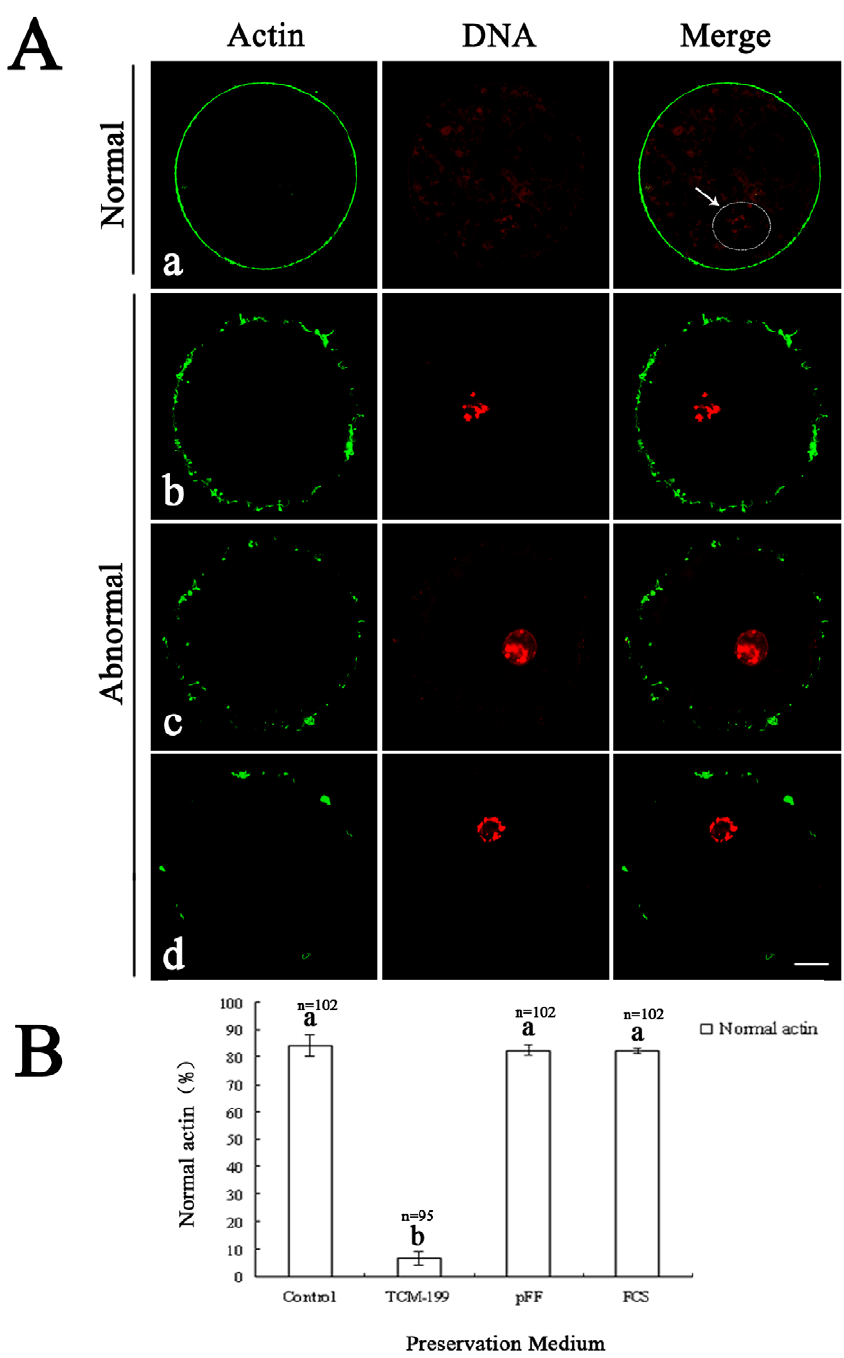
Figure 2. Effect of different media on actin configuration in porcine oocytes after preservation. A. a, represents the normal actin pattern in porcine oocytes (white arrow pointing at the white circle denotes the germinal vesicle). b, c, and d represent abnormal actin patterns. In b, actin fragments formed an incomplete ring with large punctiform aggregation. In c, small punctiform actin aggregated as an incomplete ring. In d, only some actin aggregated near oocyte membrane. Green, microfilaments; Red, chromatin. Scale bar =10 m m. B. Ratios of oocytes with normal actin configuration in control group and different preservation groups. Porcine oocytes were preserved in TCM-199, pFF and FCS at 27.5 u C for 3 d, then the actin configuration was stained with FITC-phalloidine. Normal and abnormal actin configuration were detected. The graph shows the mean 6 SEM of three independent experiments. The number ‘‘n’’ over the bars means the total treated oocyte in every group. The superscripts a, b over the bars represent values of normal actin configuration that differ significantly (P , 0.05). doi:10.1371/journal.pone.0014242.g002 [14,15]. When F-actin polymerization is inhibited, completion of a decrease in the percentage of oocytes with normal distribution of oocyte meiotic maturation and embryo development are prevent- F-actin in both GV and metaphase II (MII) stage oocytes [5]. Our ed [16]. Traditional cryopreservation methods (vitrification) cause results proved that the percentage of oocytes with normal